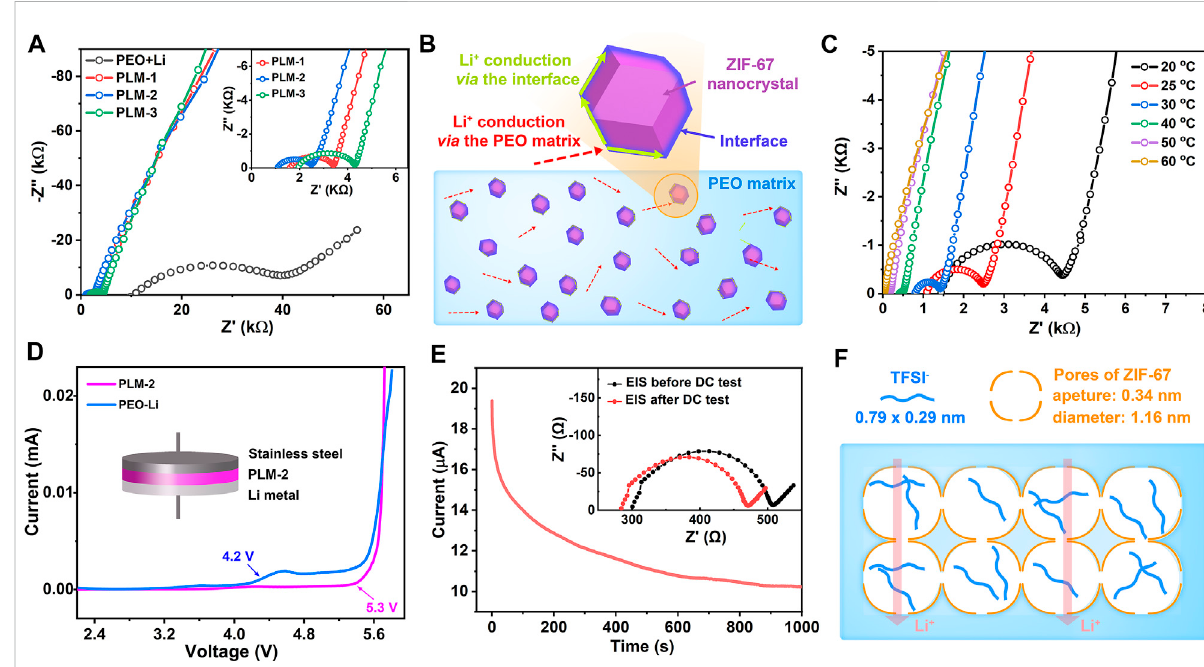
FIGURE 2 (A) The Nyquist plots of PEO-Li, PLM-1, PLM-2 and PLM-3. Inset is the enlargement curves at high frequencies. (B) Illustration of the different pathwaysforLi + conduction. (C) TheNyquistplotsofPLM-2from20to80 ° C. (D) TheLSVcurveofPLM-2from2to6 Vat60 ° C. (E) Thepotentiostatic polarization curve of PLM-2. Inset is the corresponding Nyquist curves before and after the DC test. (F) Illustration of the pore con fi nement effect in restricting the TFSI −